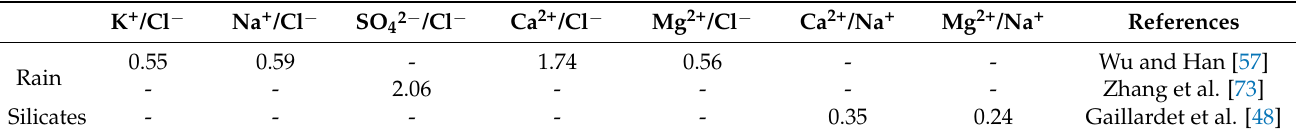
Table 3. Ionic ratios in the precipitation and